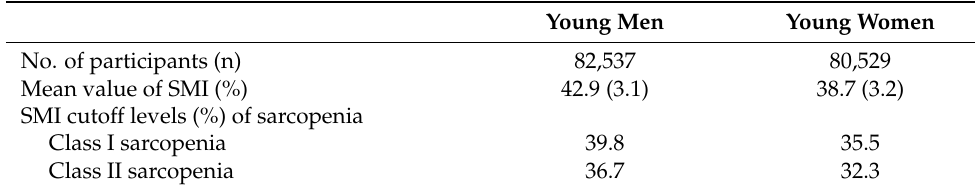
Table 2. Cutoff levels of class I and class II sarcopenia in study subjects.